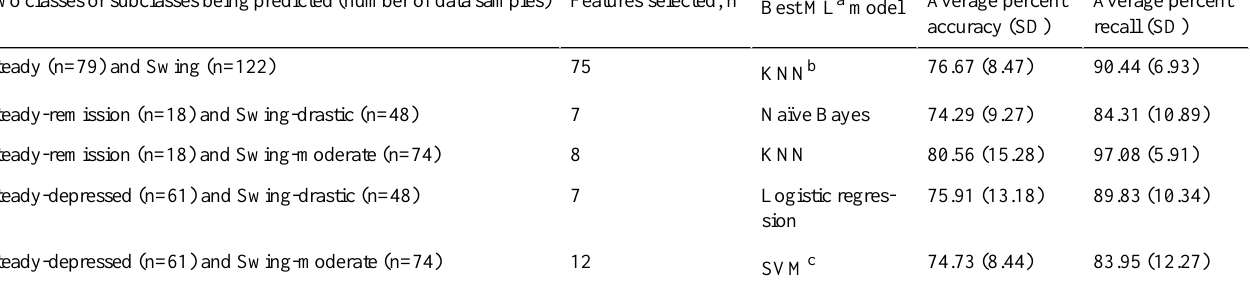
Table 7. Classification result using selected features of all data